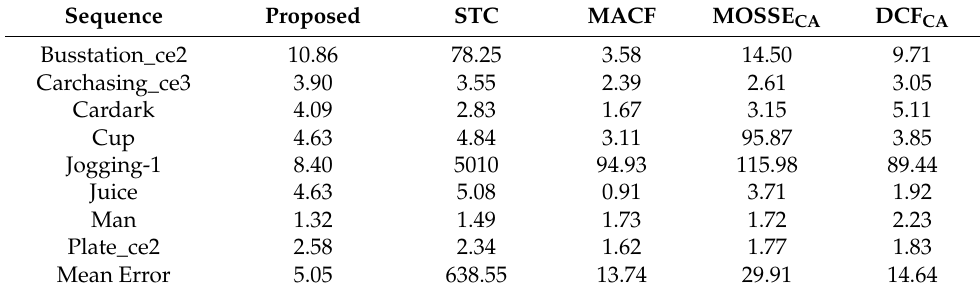
Table 2. Average center location